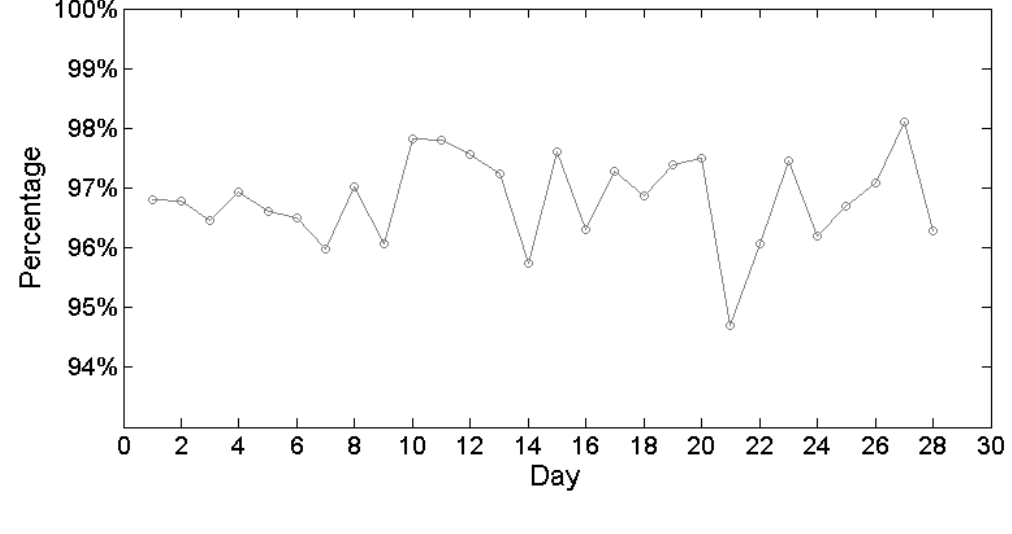
Figure 3. Plot of the percentage of SPs in city districts as a function of day of the